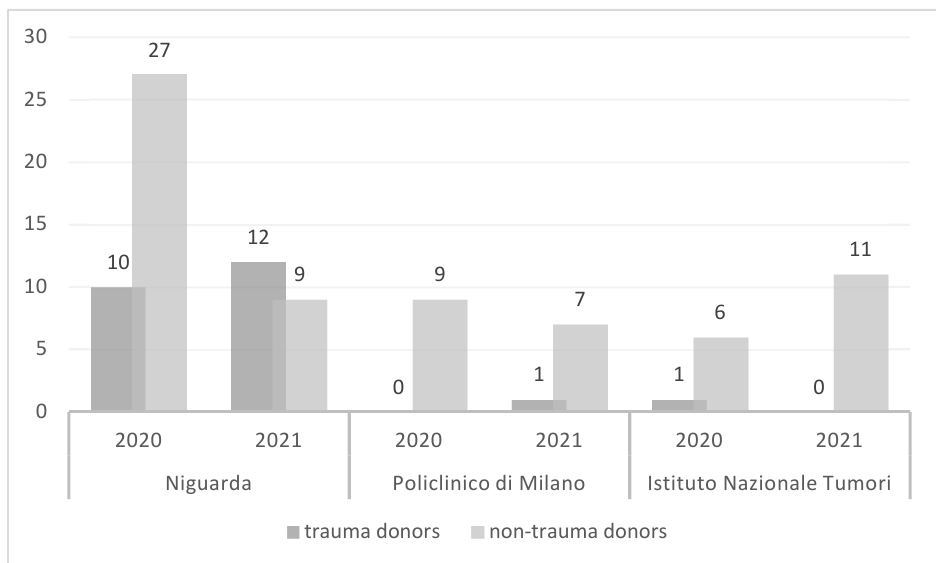
Figure 3. Organs allocation in the metropolitan area of Milan during the pandemic (i.e., 2020–2021). The Histograms show Liver donation per center according to donor type (trauma vs. non-trauma).